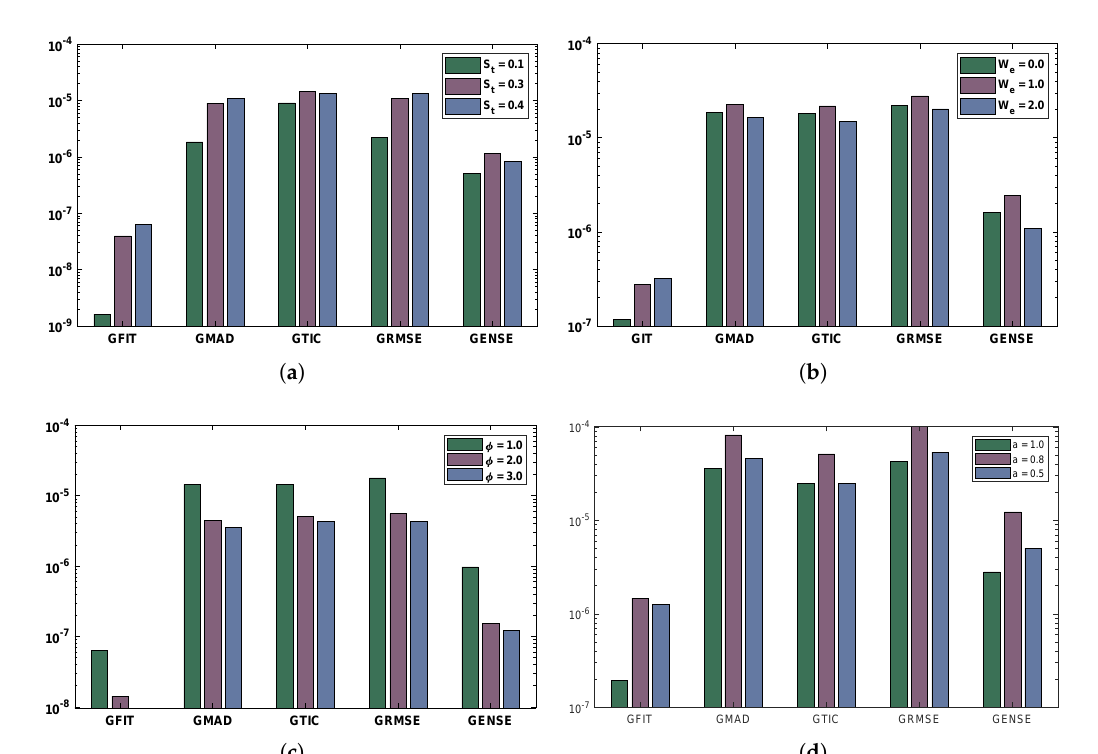
Figure 9. Global performance indicators for four scenarios of the drainage problem. ( a ) SCENARIO I. ( b ) SCENARIO II. ( c ) SCENARIO III. ( d ) SCENARIO IV.